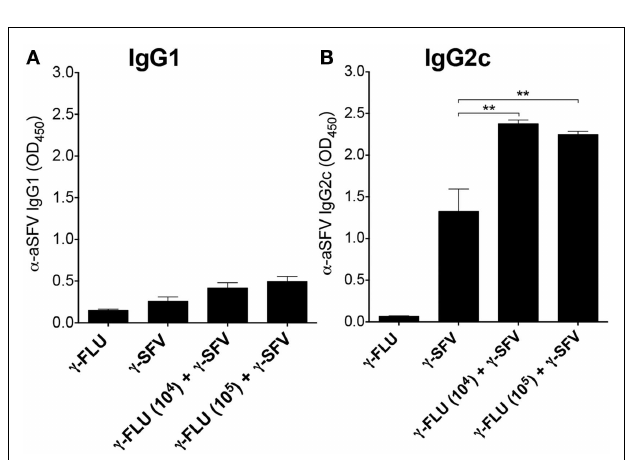
FIGURE 4 | Co-administration of γ -FLU and γ -SFV enhances SFV-specific IgG2c responses . Mice were injected i.v. with a single dose of γ -SFV (10 7 PFU equivalent/mouse) or co-injected with various doses of γ -FLU (10 4 , 10 5 TCID50 equivalent/mouse). SFV-specific IgG1 (A) and IgG2c (B) levels in the serum at day 20 post-vaccination were analyzed by direct ELISA using a serum dilution of 1/200. Sera from γ -FLU vaccinated mice served as negative controls. Data represent mean ± SEM ( n = 3) ** p <